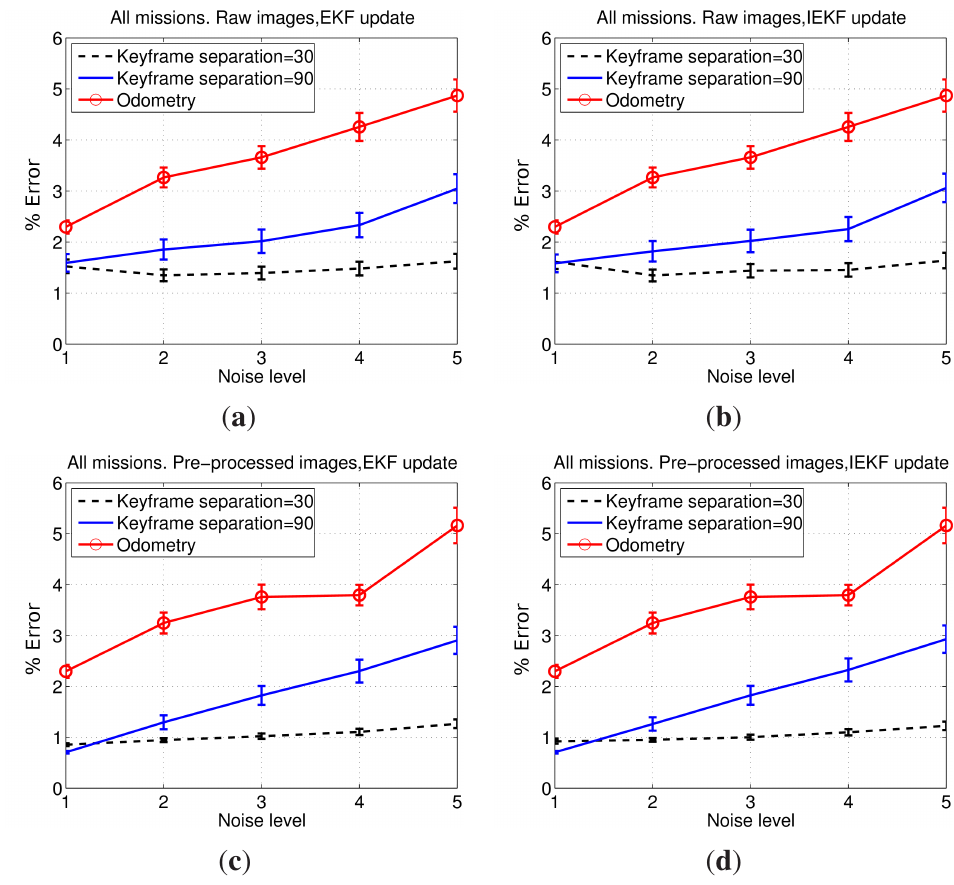
Figure 12. Mean and standard deviation of the errors corresponding to 30 and 90 keyframe separations for: ( a ) raw images and EKF update; ( b ) raw images and IEKF update; ( c ) filtered images and EKF update; and ( d ) filtered images and IEKF